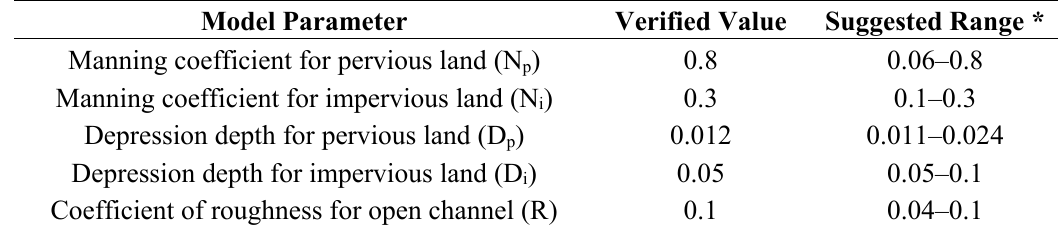
Table 2. Major model parameters for flow simulation using SUSTAIN model and its verified values in this study.